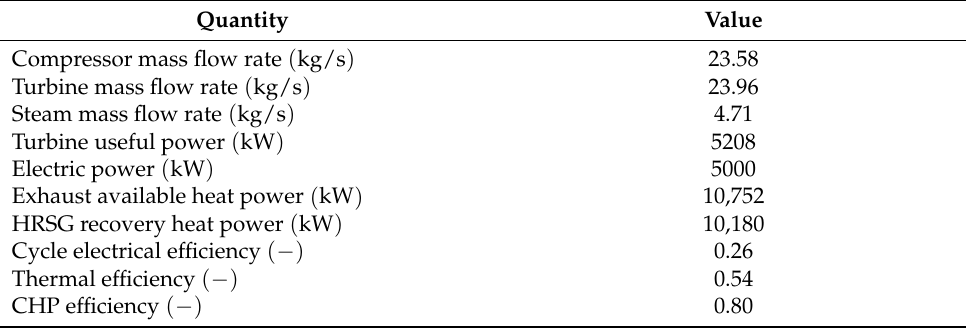
Table 3. Operational parameters and overall performance of the